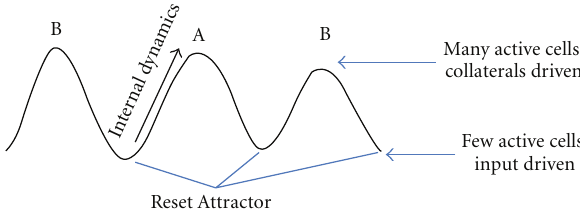
Figure 4: Pictorial representation of the dynamics in our